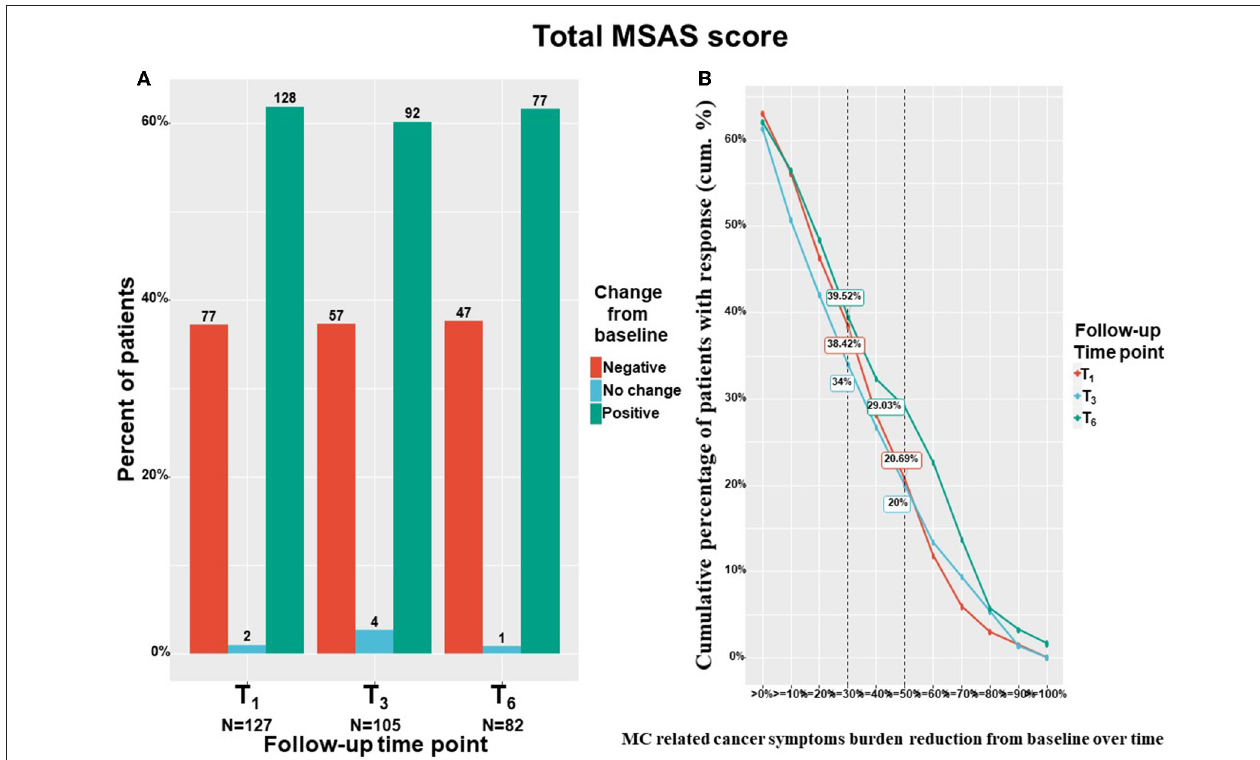
FIGURE 4 | Total cancer symptom burden change from baseline. T 1 , 1-month Follow-Up; T 3 , 3-month Follow-Up; T 6 , 6-month Follow-Up: MSAS, Memorial Symptom Assessment Scale; (A) Negative indicate patients that reported on higher pain intensity at a follow-up compared to baseline; Positive indicate patients that reported on lower pain intensity at a follow-up compared to baseline; No change indicate patients that reported on the same pain intensity at a follow-up compared to baseline; MC, medical cannabis; The percentages on the Y-axis indicates the cumulative percentage of patients with response; For (B) , every point on the X-axis represent the percentage of MC related pain intensity reduction from baseline, no change values or an increase of pain intensities are not represented in this figure; Numbers of patients are based on patients that reported fully on the measures at baseline and at the corresponding follow-up time point; (B) displays percentages from the entire cohort ( n = 212 at T 1 , n = 158 at T 3 , n = 126 at T 6 ) but only positive (MSAS score improvement) reports are